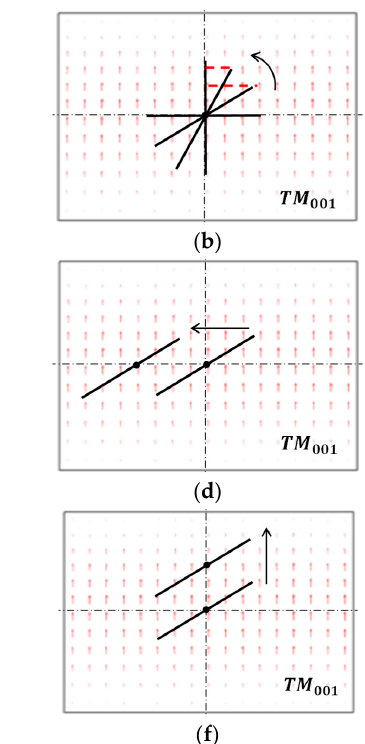
Figure 5. Simulated results. ( a ) 𝑓 (cid:2868)(cid:2869)(cid:2868) and ( b ) 𝑓 (cid:2868)(cid:2868)(cid:2869) response to cracks at the center of the ground plane; ( c ) 𝑓 (cid:2868)(cid:2869)(cid:2868) and ( d ) 𝑓 (cid:2868)(cid:2868)(cid:2869) response with the crack position moving leftwards; ( e ) 𝑓 (cid:2868)(cid:2869)(cid:2868) and ( f ) 𝑓 (cid:2868)(cid:2868)(cid:2869) response with the crack position moving upwards; ( g ) 𝑓 (cid:2868)(cid:2869)(cid:2868) and ( h ) 𝑓 (cid:2868)(cid:2868)(cid:2869) response with the crack position moving leftwards and upwards simultaneously.